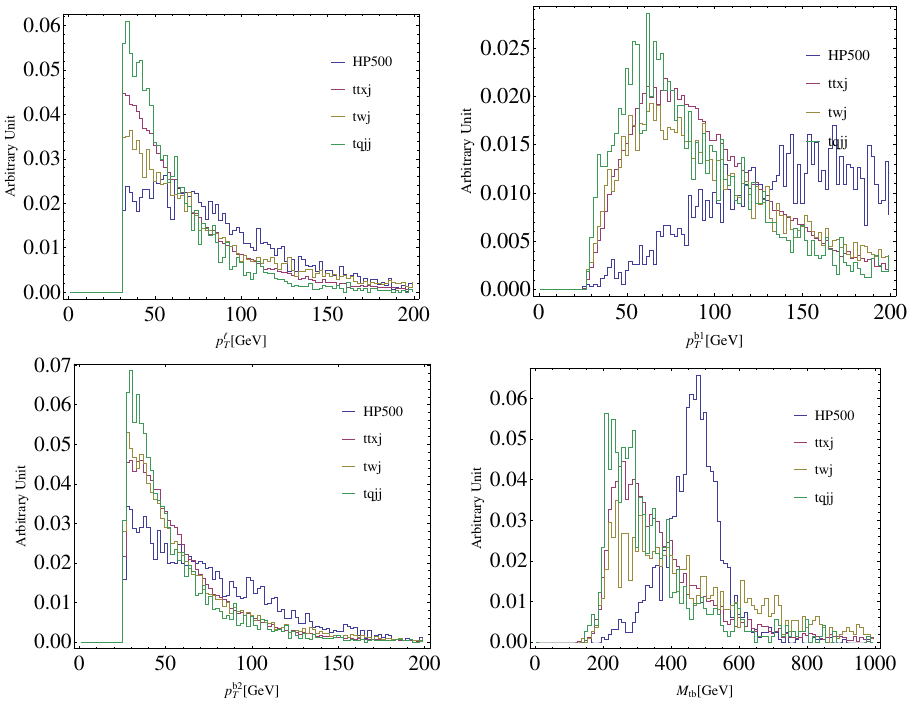
Figure 1 . Kinematic distributions of p ‘ , p b 1 , p b 2 and m tb after the VBF cuts for the charged T T T Higgs boson mass m = 500 GeV. Here \HP500" and \ttxj", \twj", \tqjj" denote the signal and H (cid:6) backgrounds t (cid:22) t , tW , tq ,